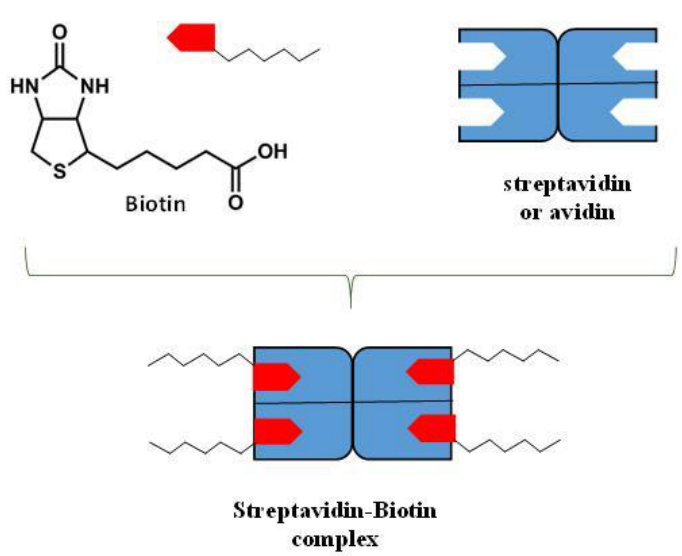
Figure 7. Schematic representation of the interaction of biotin with the tetrameric protein streptavidin. Mixed liposome formed by PEGylated distearoylphosphatidylethanolamine lipid (PEG-DSPE) and biotin-(CH 2 ) n -hexadecylphosphatidylethanolamine amphiphile showed the ability to form